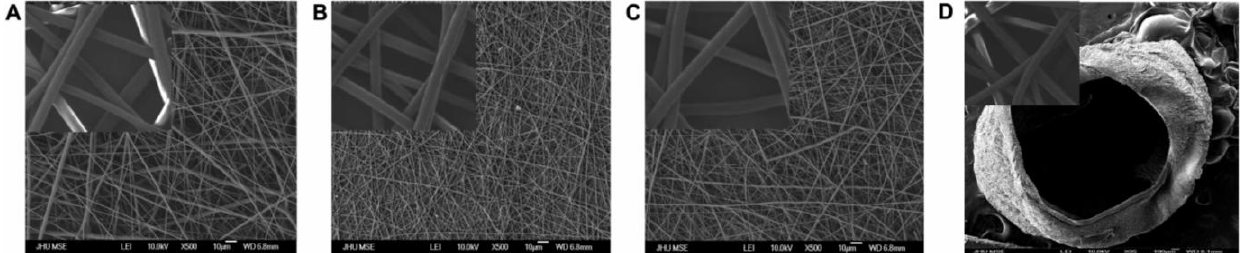
Figure 1. SEM images of electrospun nanofibers of (A) PCL (640 ± 83 nm), (B) collagen (330 ± 17 nm), and (C) PCL/collagen (510 ± 21 nm). PCL/collagen nanofibers weaved into a tubular scaffold are depicted in (D). Insets: Magnified